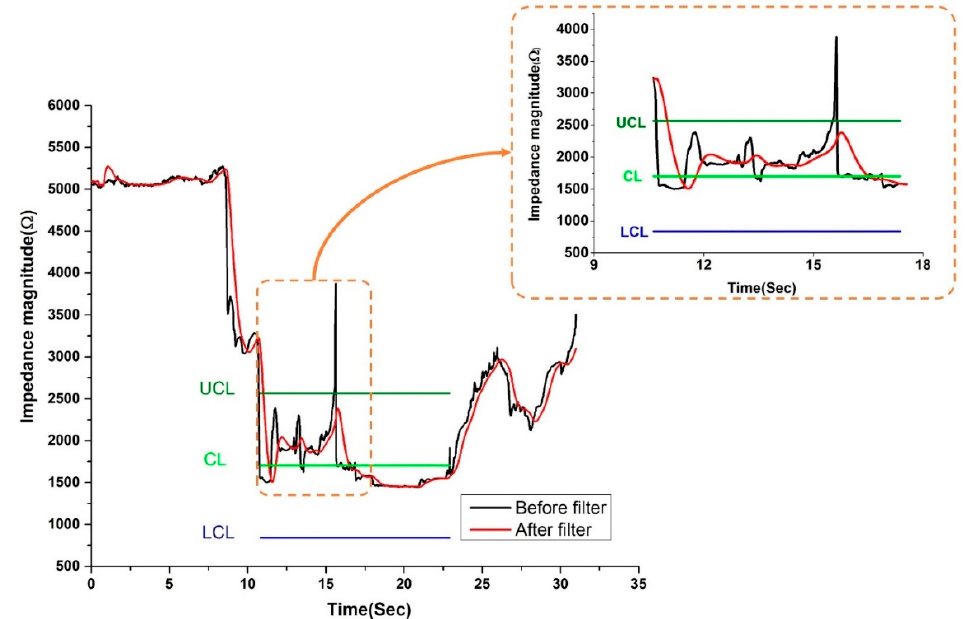
Figure 8. Real-time impedance monitoring at 100 kHz when the monopolar needle moved from the subcutaneous tissue into the intra-articular space.